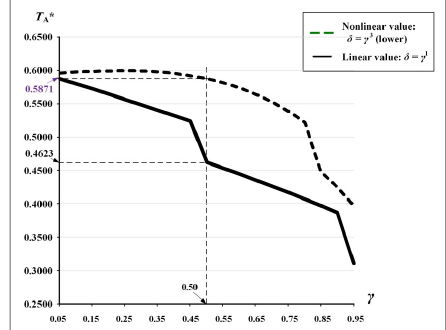
Fig. 7. The behavior T A * regarding the linear and nonlinear relationships of δ and γ